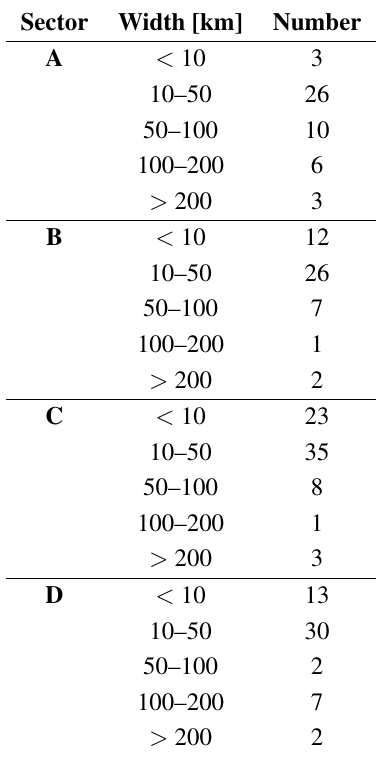
Table 3. Widths of calving fronts in the four sectors (see